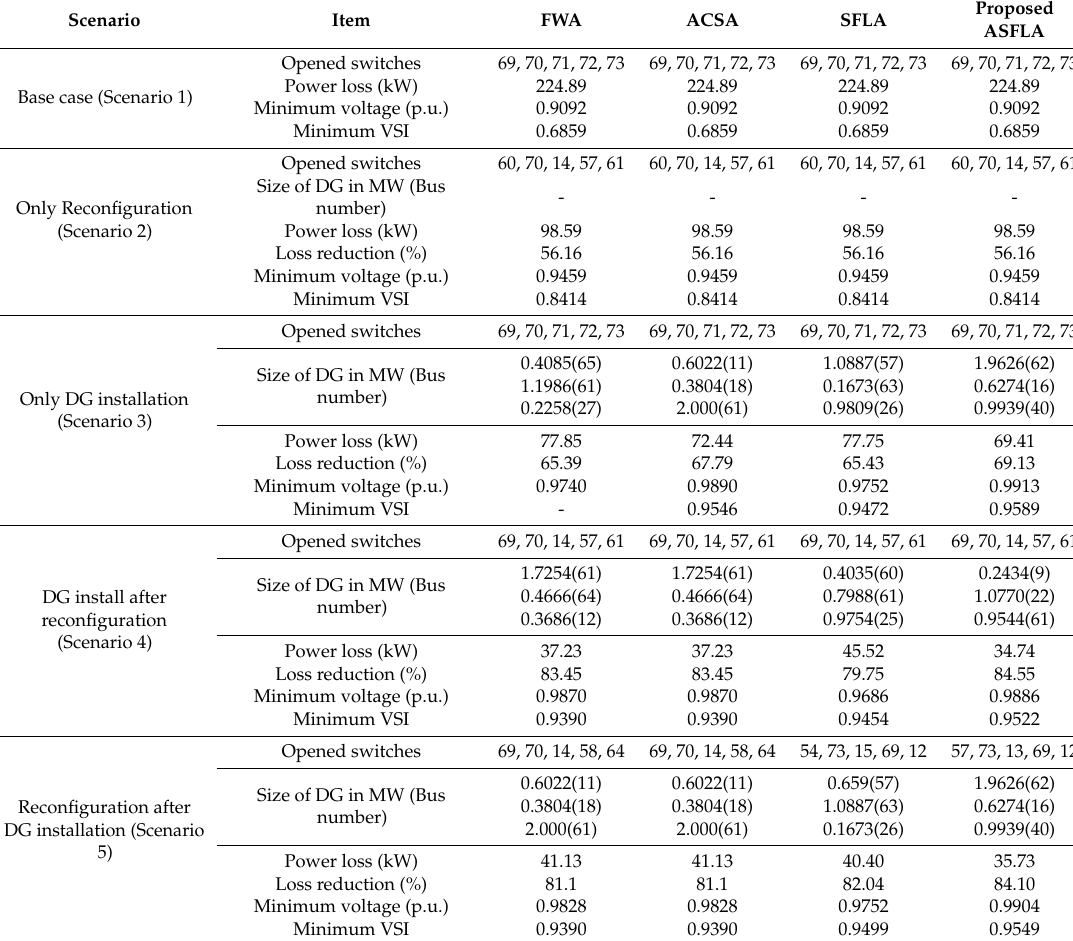
Table 2. Performance analysis of proposed ASFLA on the 69-bus